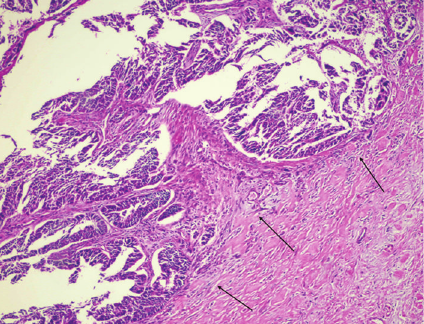
Figure 4: Neoplastic cell islands within fibrotic stroma of pancreas showing similar feature to that of in ovary (arrows), × 200, H &